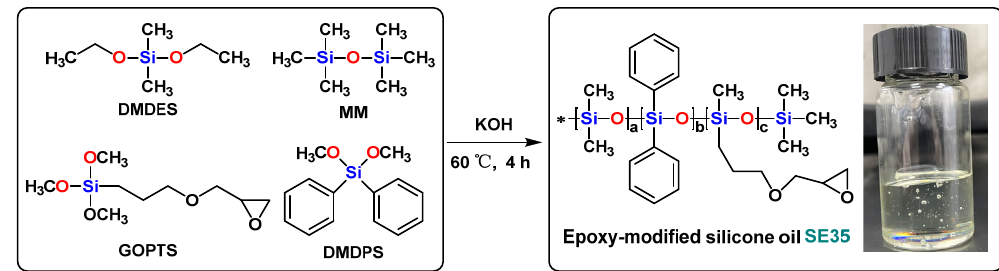
Figure 2. Synthesis of epoxy-modified silicone oil (SE35).